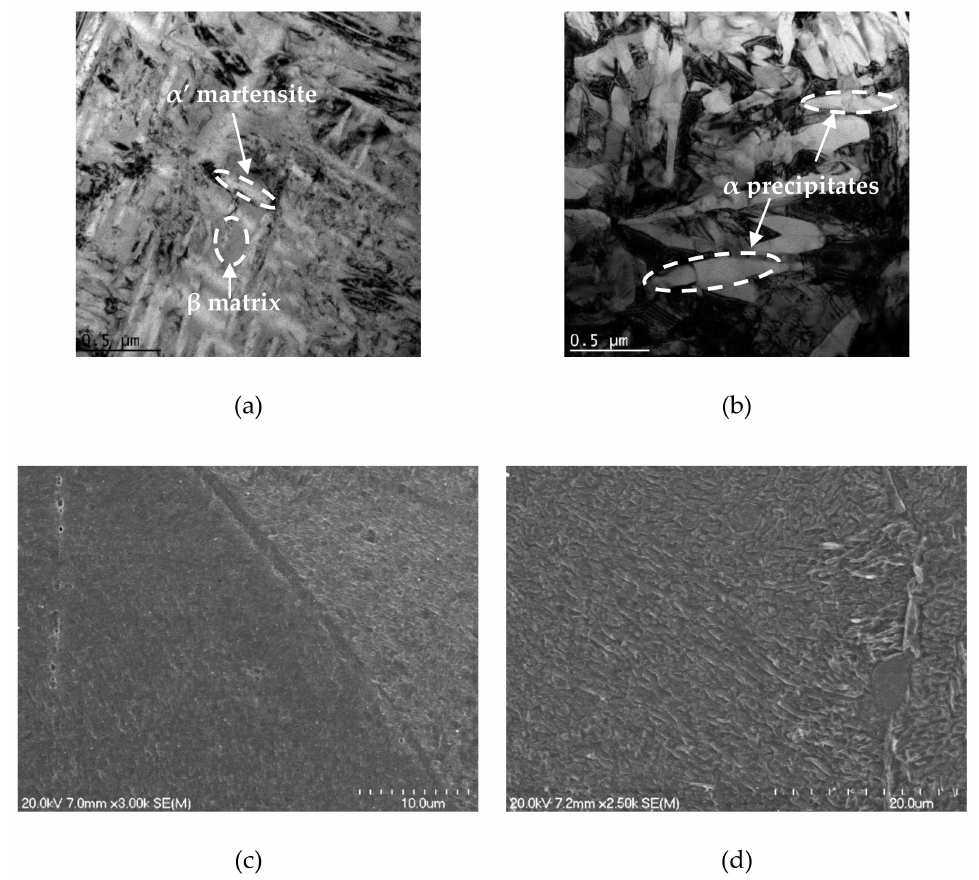
Figure 3. Microstructures of the extruded and heat-treated PM Ti-5Fe alloy: ( a ) TEM micrograph of the Ti-5Fe alloy solution treated at 900 ◦ C and water quenched, ( b ) TEM micrograph after solution treatment and aging (STA) with aging at 550 ◦ C for 4 h, ( c ) SEM micrograph of alloy after STA with aging at 550 ◦ C for 4 h, and ( d ) SEM micrograph of alloy after STA with aging at 650 ◦ C for 4